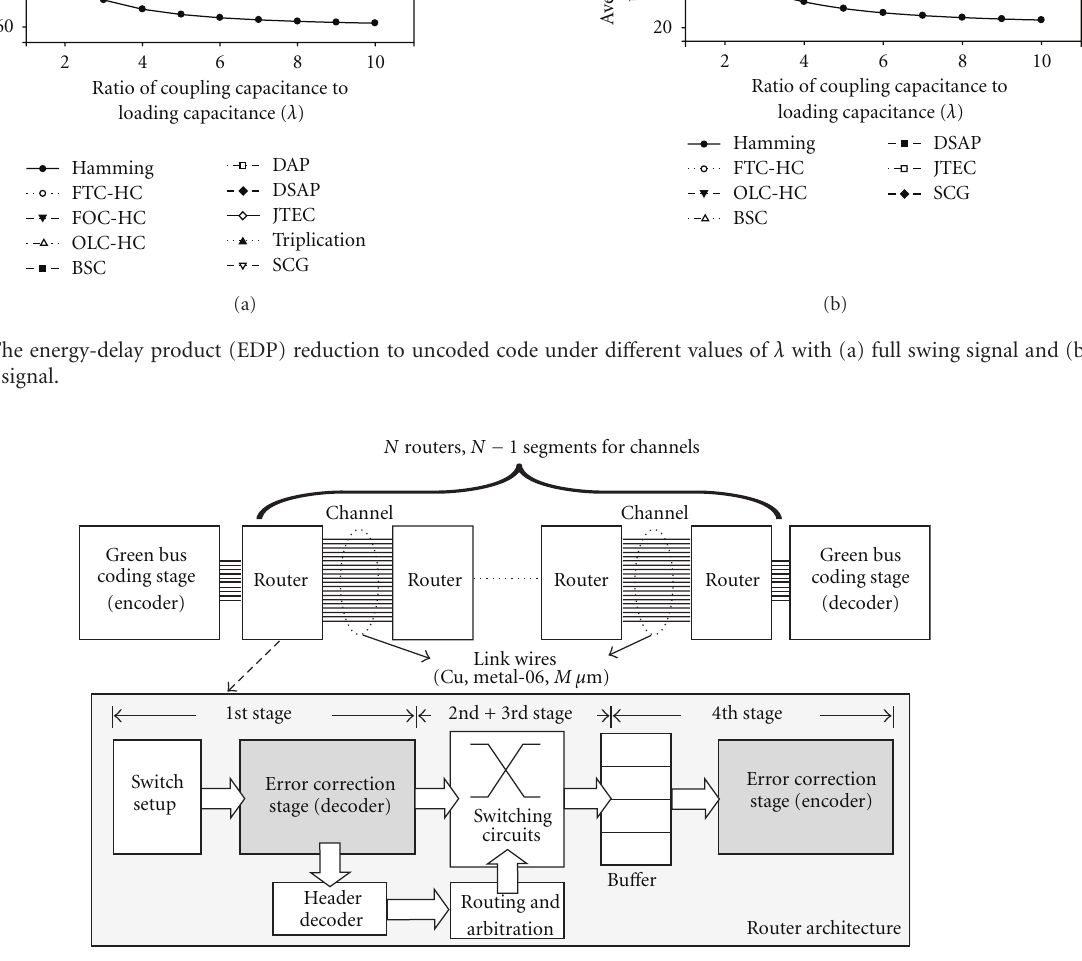
Timing delay variation is caused by the crosstalk e ff ect, process variation, width variation, and voltage variation.